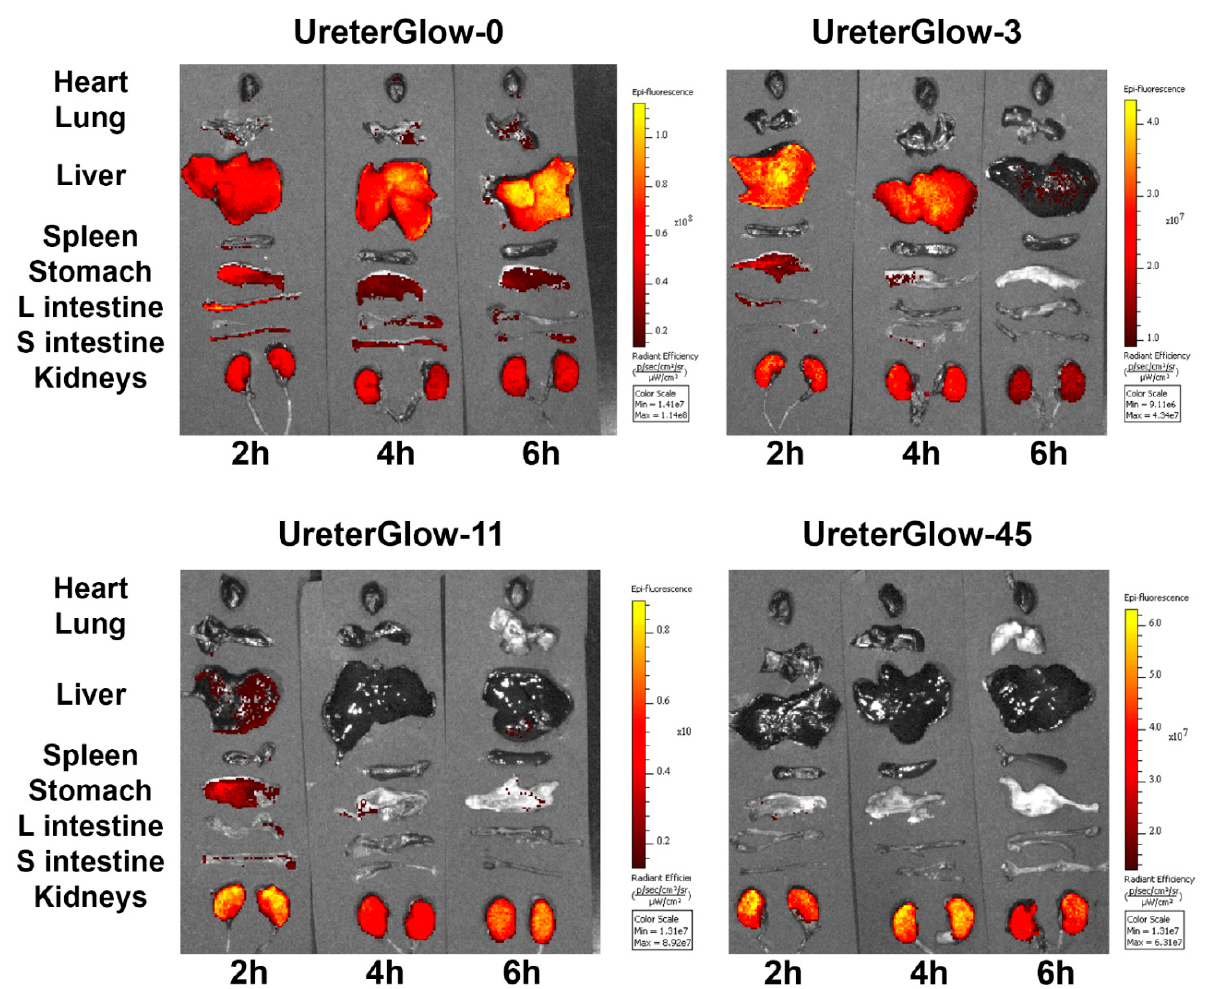
Figure 2. In vivo biodistribution of UreterGlow conjugates. Mice were administered 10 nmol of various conjugates ( n = 1 per time point per conjugate) via tail vein injection. After varying times, mice were euthanized and their organs were removed. Organs were imaged and the fluorescence intensity recorded.